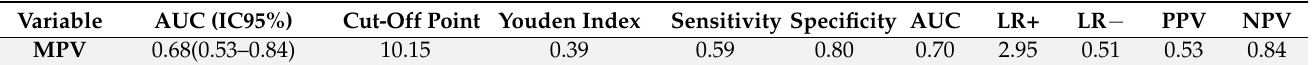
Table 3. Analysis of the calculated cut-off point for MPV as a predictor of severity of SARS-CoV-2